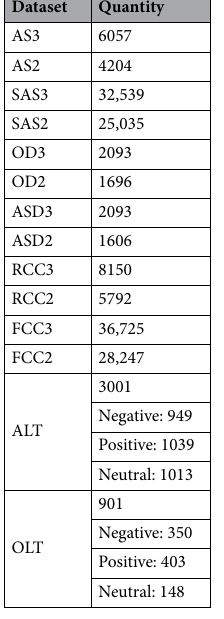
Table 2. Details of the components of the corpus in